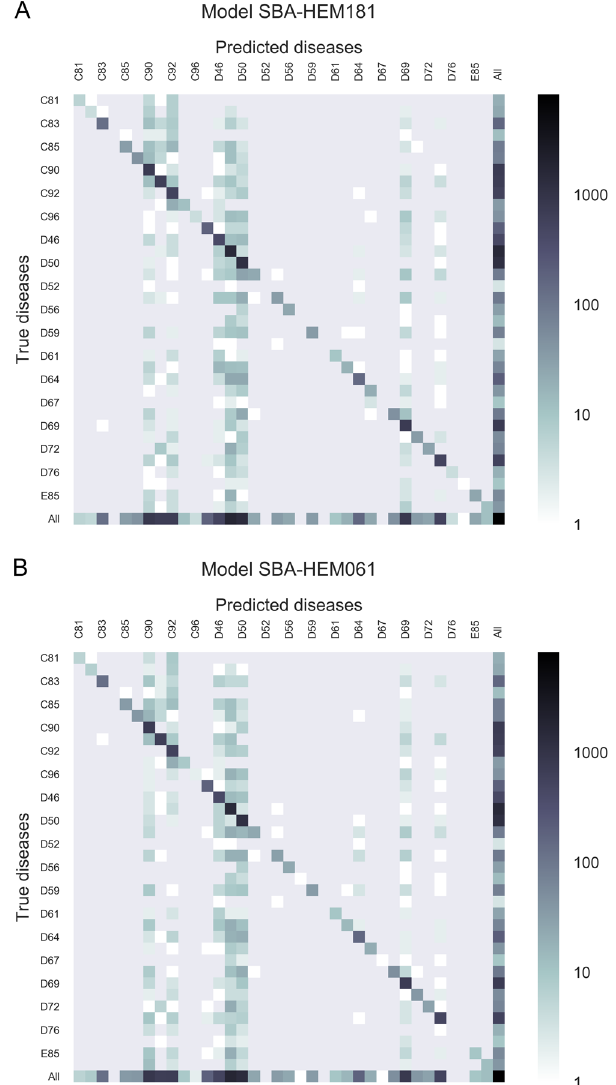
Figure 7. Confusion matrix for the five most likely diseases for both predictive models (A ) SBA-HEM181 and ( B ) for SBA-HEM61. Each column of the matrix represents instances of predicted diseases, while each row represents instances of actual diseases. The frequencies are marked on a logarithmic scale.